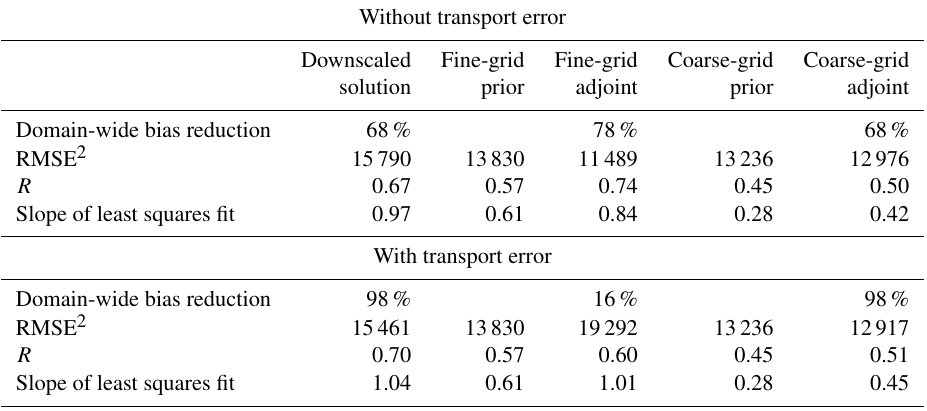
Table 1. Downscaling performance evaluation via OSSE 1 . Without transport error Downscaled Fine-grid Fine-grid Coarse-grid solution prior adjoint prior adjoint Domain-wide bias reduction